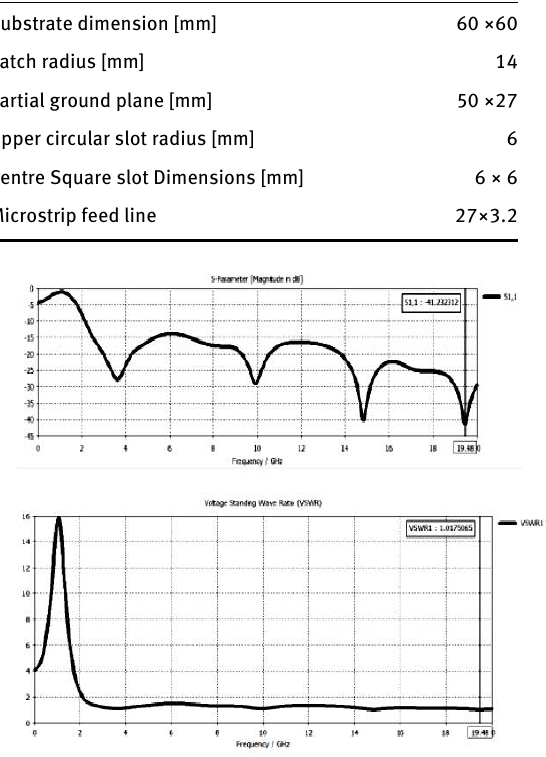
Figure 2: S 11 -parameter and VSWR Vs Frequency